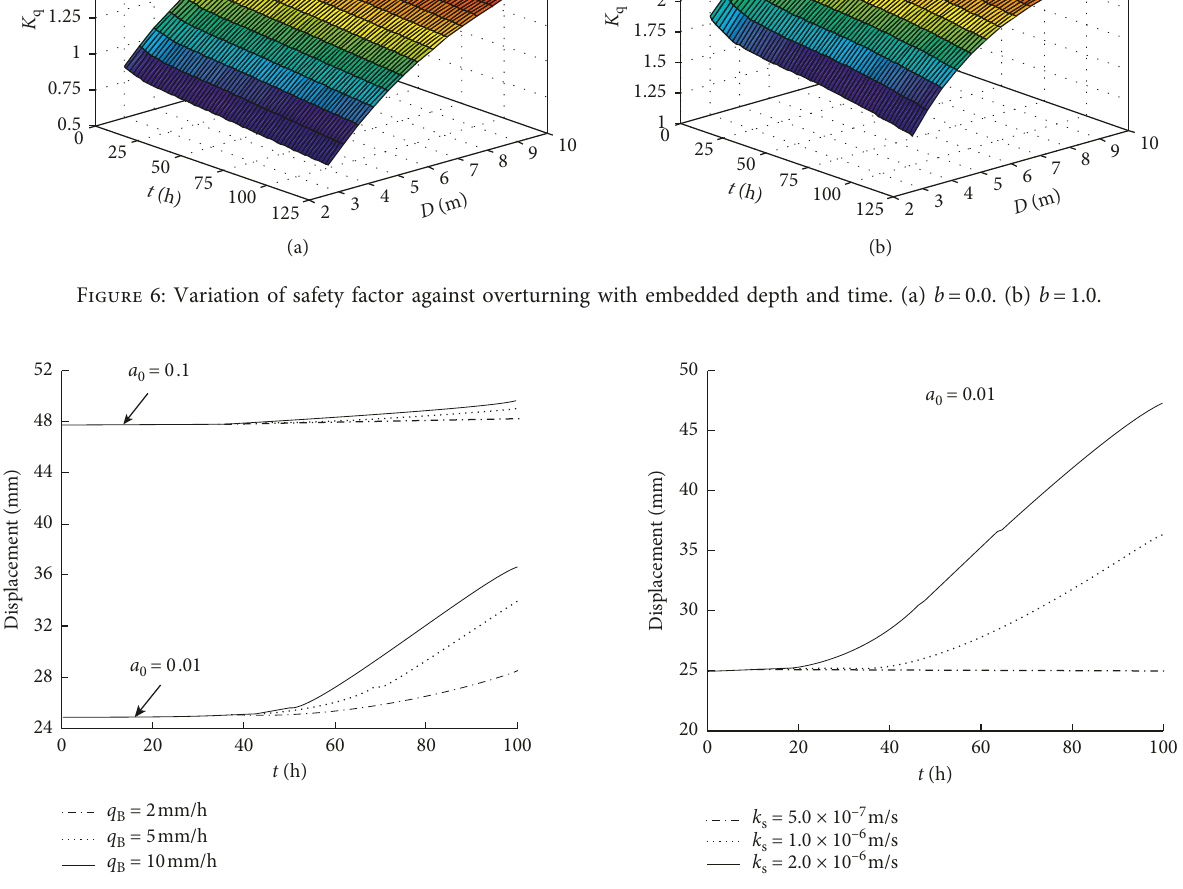
Figure 8: Effect of saturated permeability coefficient on horizontal displacement of pile